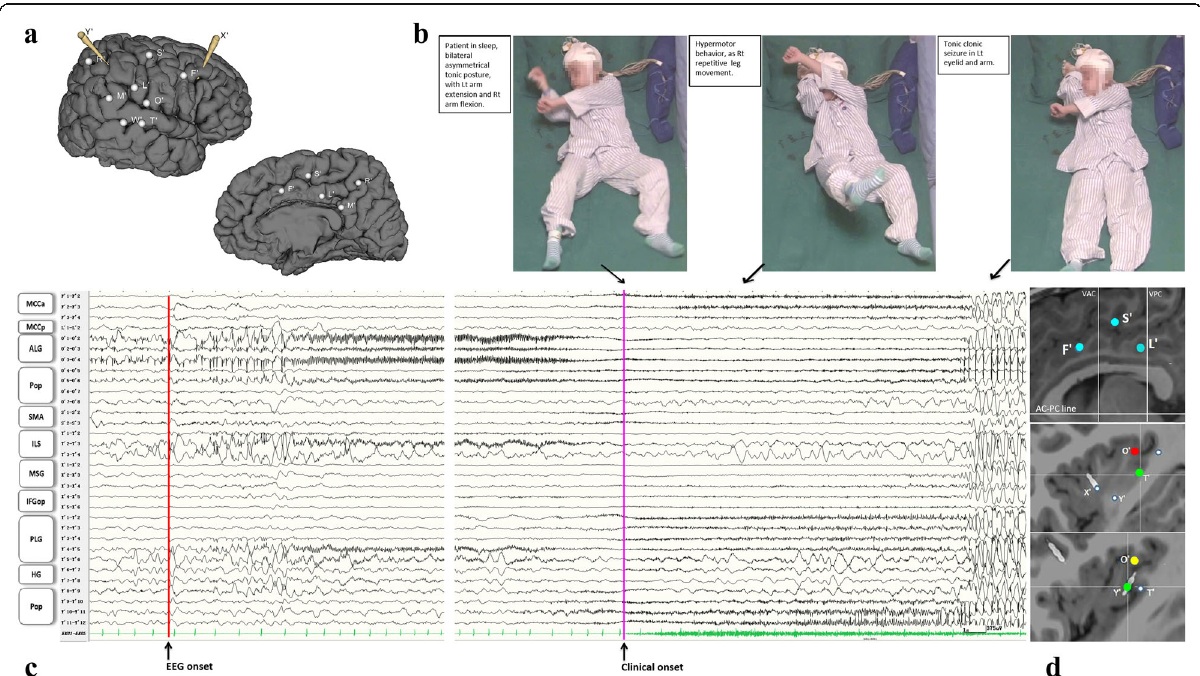
Fig. 1 Anatomo-electro-clinical features of Patient 5. a Lateral and medial view of all implanted stereotactic electrodes on a three-dimensional reconstruction of the cortical surface of the brain. b Semiology of this patient was characterized by bilateral asymmetric tonic posture of left upper limb extension and right arm flexion, followed by hyperkinetic behavior (repetitive movement of the right leg) and left eyelid/arm tonic clonic seizure. c SEEG activity at seizure onset exhibited immediate spike and polyspike discharges followed by a low-voltage fast activity in the ALG of insular cortex (electrodes O ’ 1 – 3, red-color in panel d ), which spread to the parietal operculum (electrodes O ’ 4 – 5, yellow-color in panel d ) and posterior long gyrus PLG and inferior circulating sulcus (electrodes Y ’ 4 – 5, T ’ 2 – 3, green-color in panel d ). Clinical symptoms start when ictal discharges spread to MCC (electrodes F ’ 1 – 2,L ’ 1, light blue in panel d ) and SMA (electrodes S ’ 1 – 2, light blue in panel d ). d Sagittal view of T1 MRI with electrodes in insula and mesial parts of the